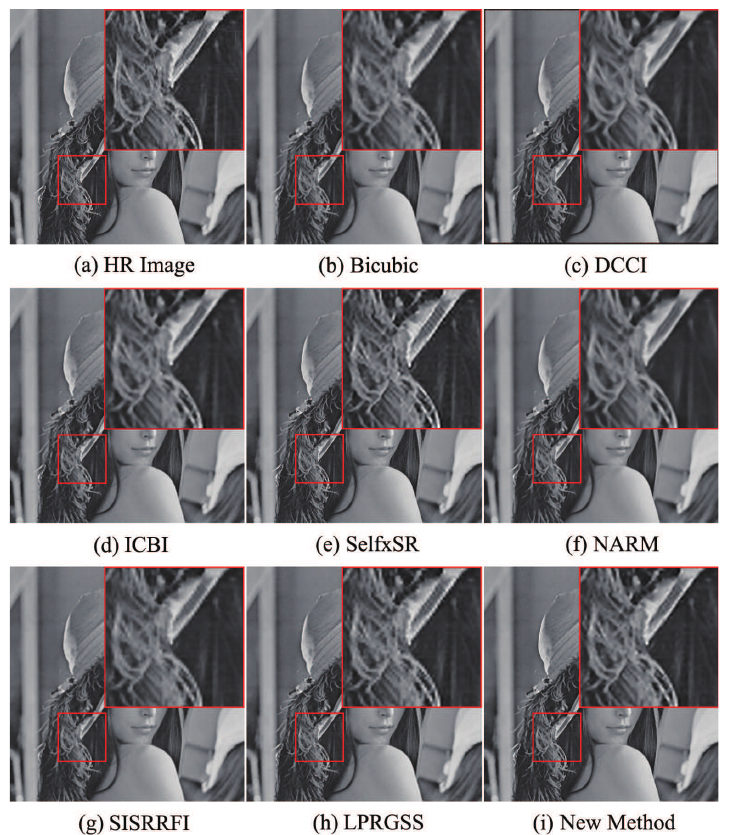
Figure 5. Leena images magnified by eight methods.